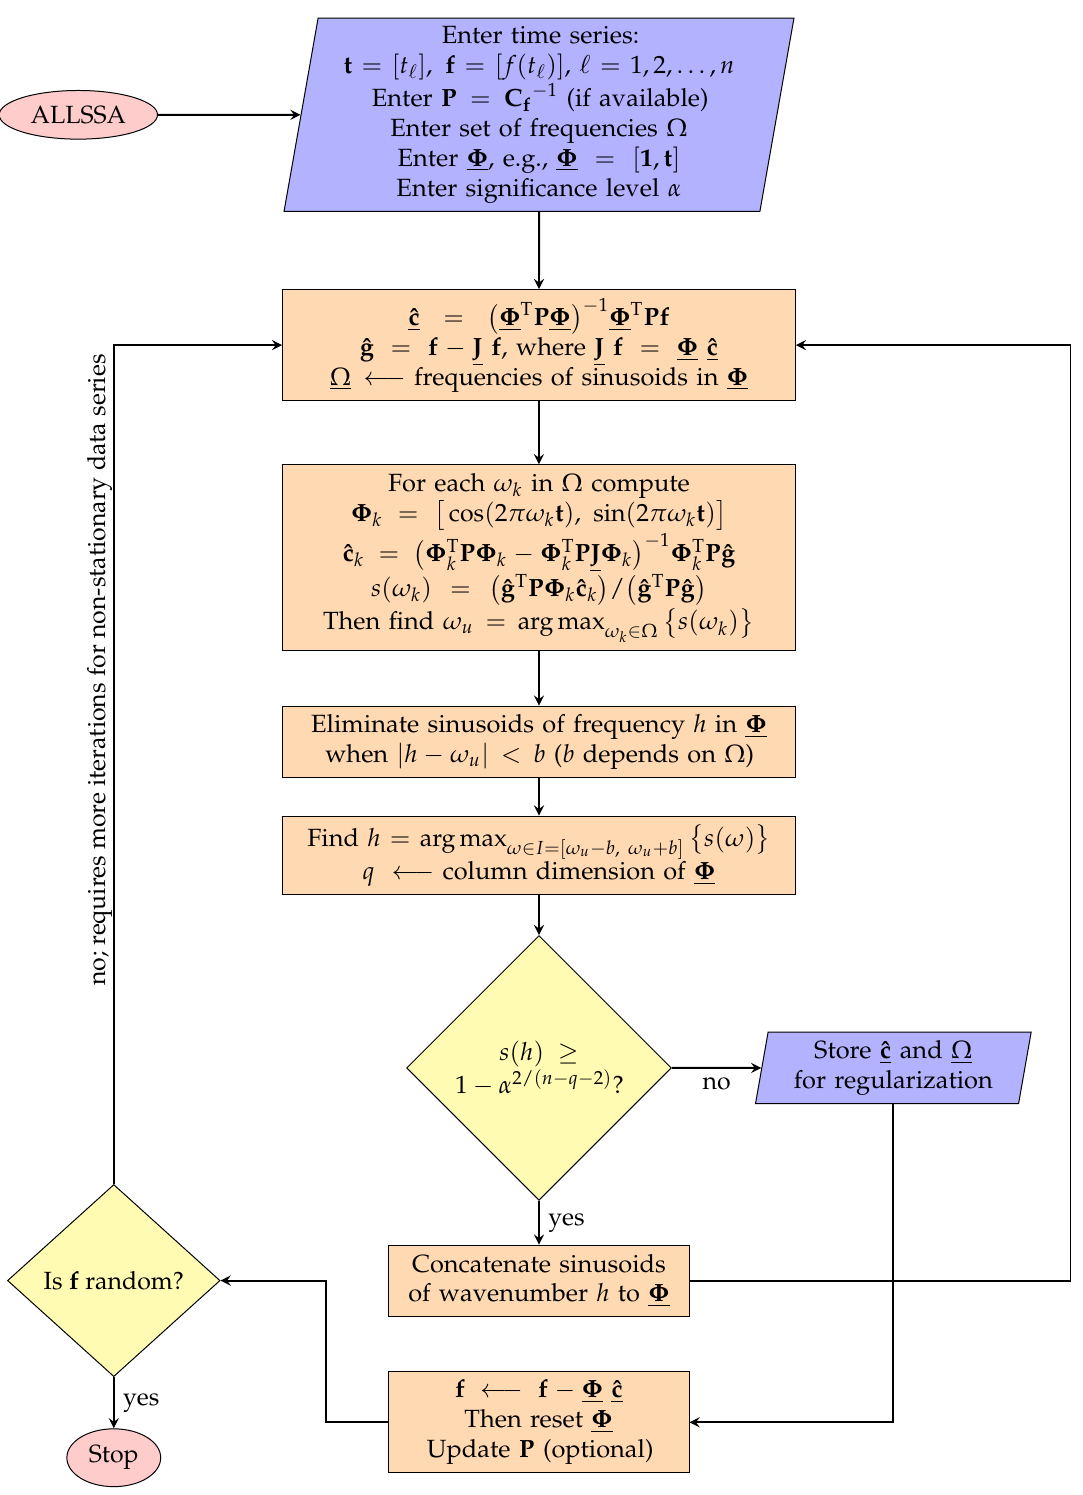
Figure A4. A flowchart of the ALLSSA